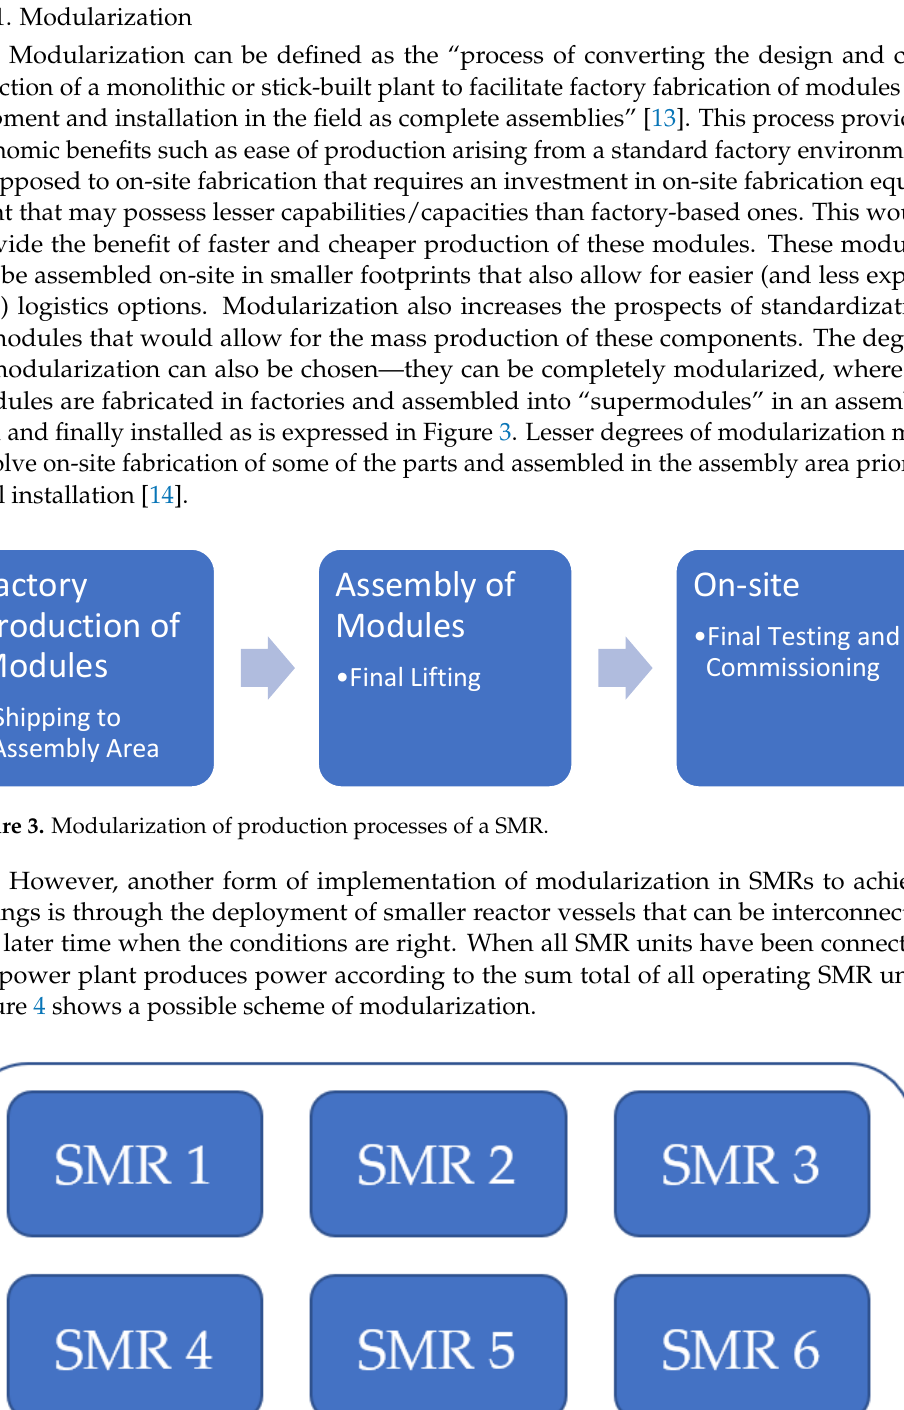
Figure 2. Classification scheme by technological generations.